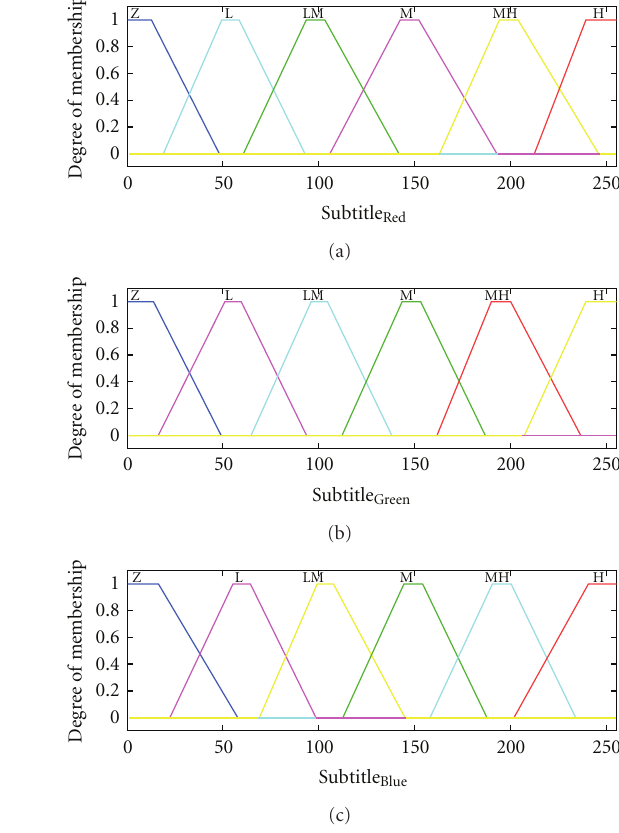
Figure 7: Membership functions of the outputs (Subtitle Red , Subtitle Green , and Subtitle Blue